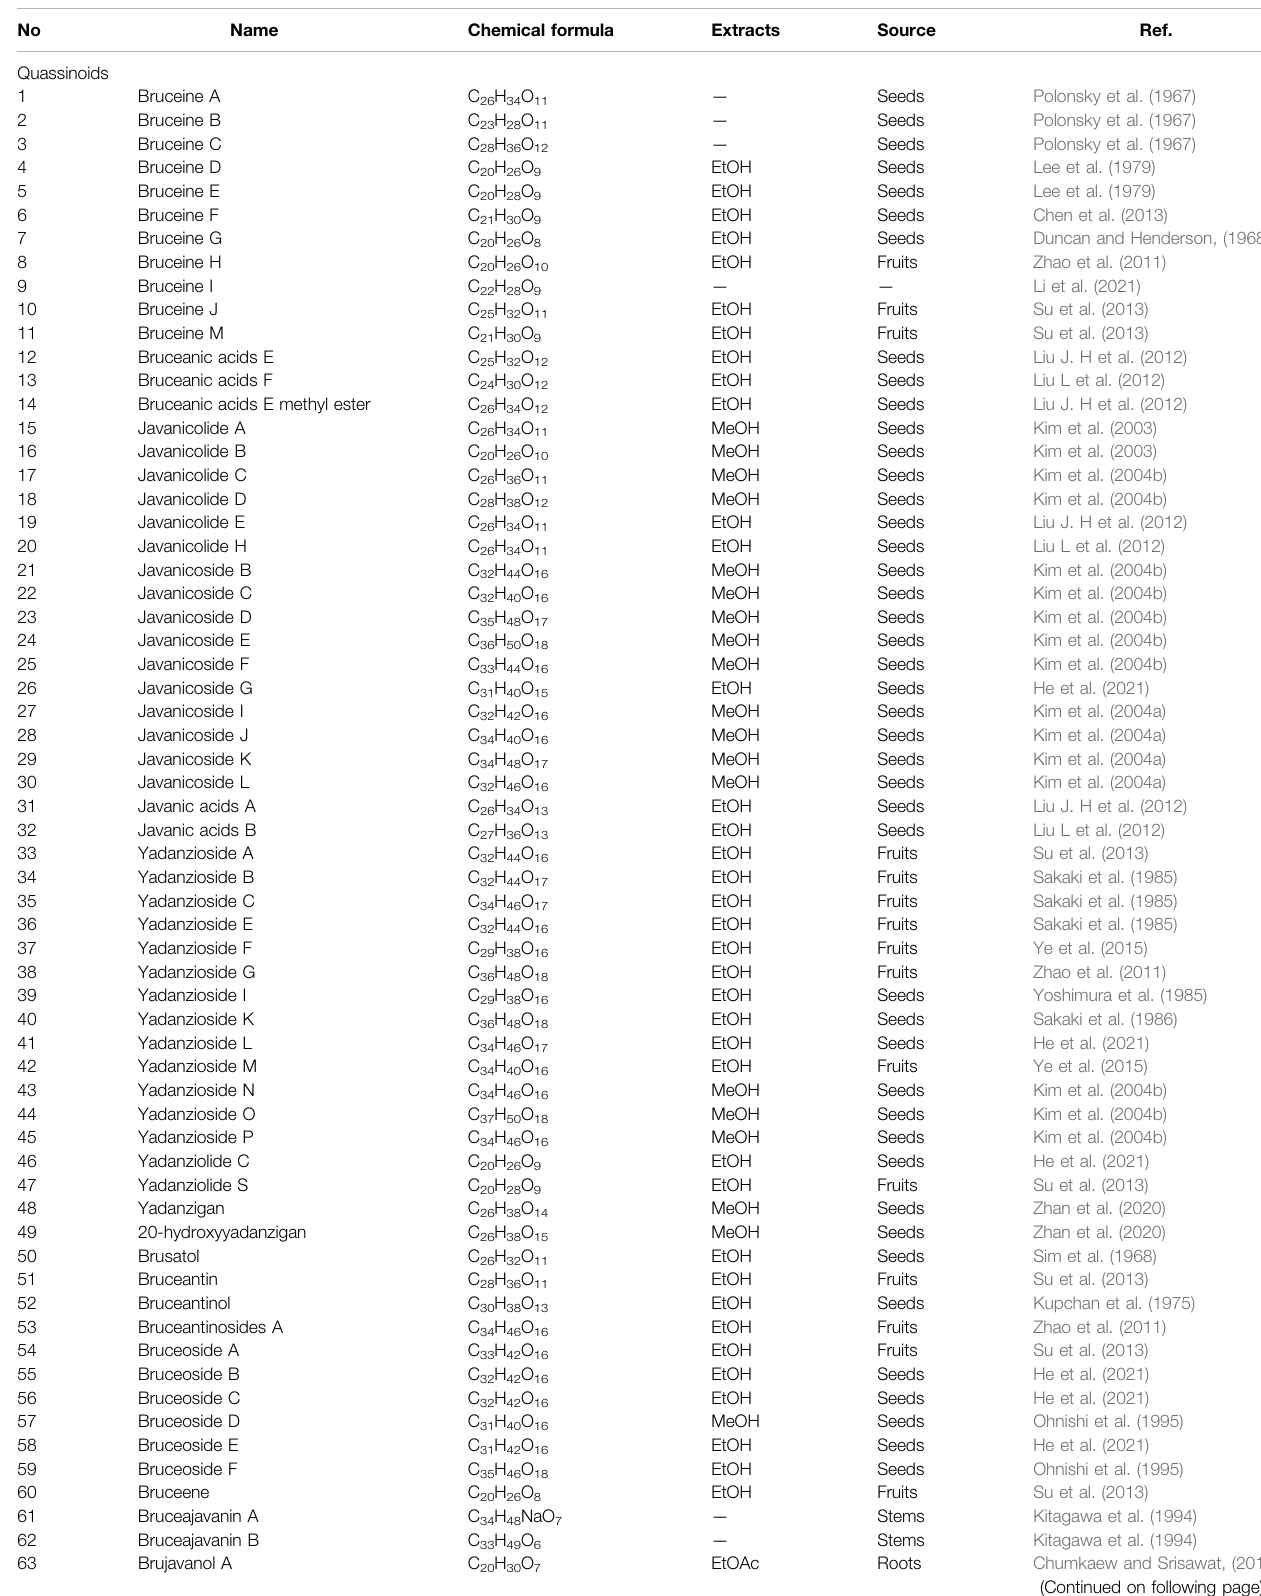
TABLE 1 | The molecular formulae and source of the constituents isolated from B. javanica .